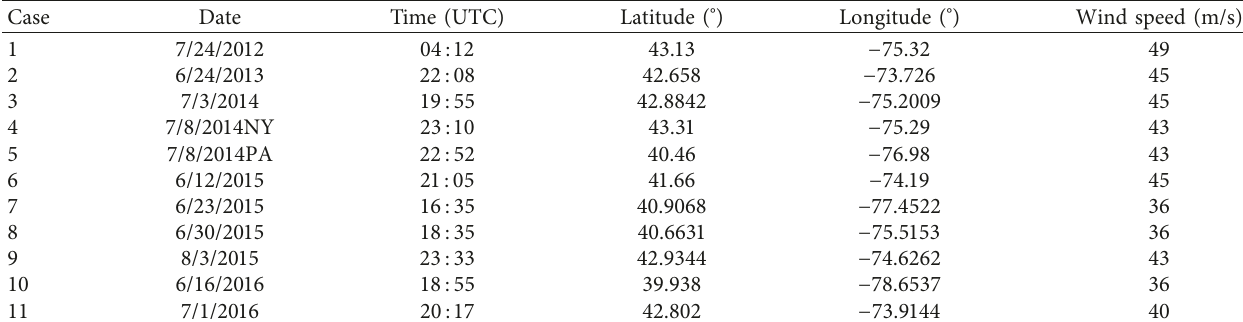
Figure 1: General map of the study area, highlighting key Table 1: List of microbursts examined in this study.